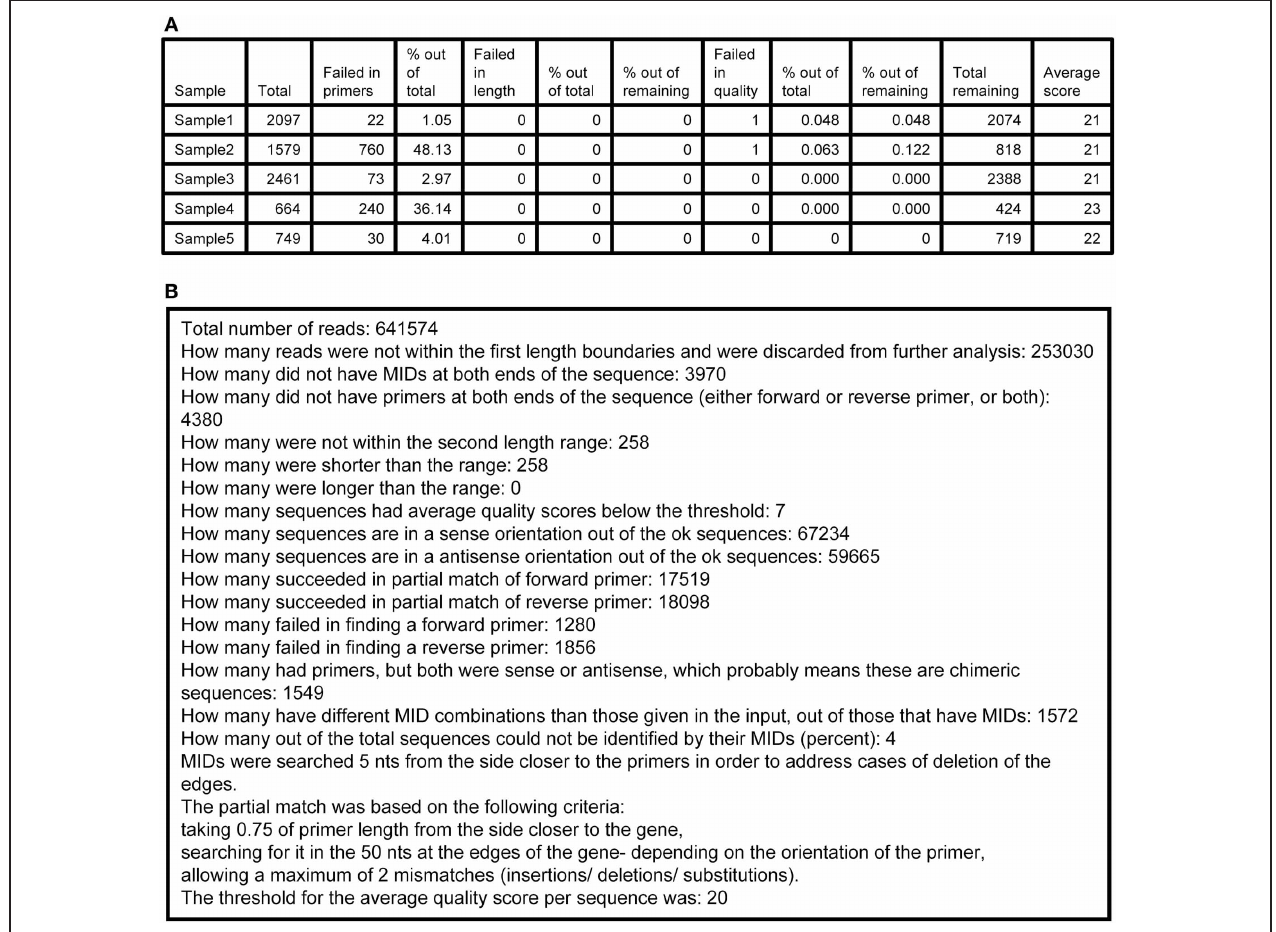
FIGURE 3 | A sample of an Ig-HTS-Cleaner log.txt output file. (A) The first part of the file (after importing the .txt file into a table). “Sample” is the sample name, inserted in the input file. “Total” represents the total number of sequences received from the sequencer before cleaning (as counted after MID identification). “Failed in primers” represents the number of sequences without primers at both ends. “% out of total” means the % of the “Failed